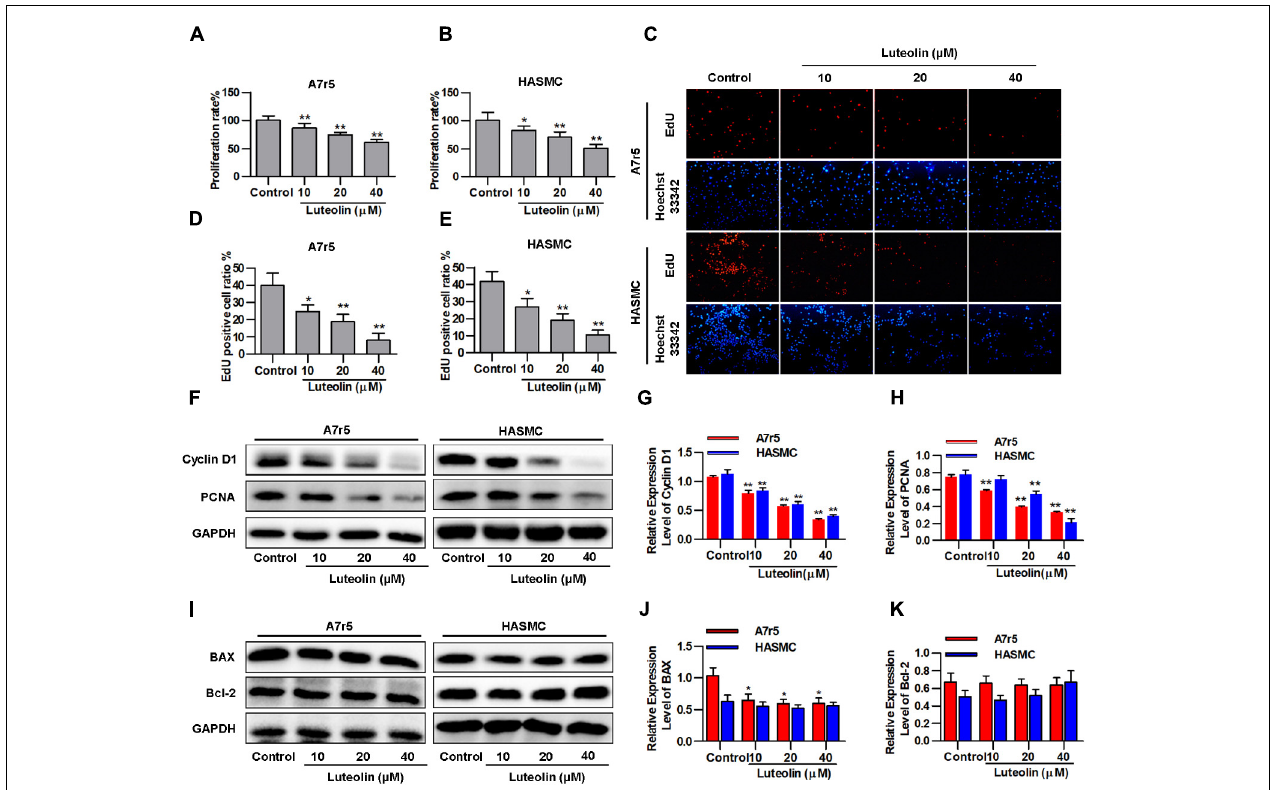
FIGURE 1 | Luteolin suppresses vascular smooth muscle cell (VSMC) proliferation without inducing apoptosis. (A , B) A7r5 and HASMC cells were incubated with different concentrations of luteolin (10, 20, and 40 µ M) for 48 h, and then VSMC proliferation was tested by MTS assays ( n = 6). (C) EdU proliferation assay. The red regions (EdU) in the images represent proliferating cells, and the blue regions (Hoechst 33324) represent the nuclei of all cells. (D , E) Percentage of EdU-positive VSMCs (the proliferation ratio was tested by assessing Hoechst 33324/EdU staining; n = 3). (F) A7r5 and HASMC cells were incubated with luteolin (10, 20, and 40 µ M) for 24 h, and the expression of Cyclin D1 and PCNA was tested by western blotting. (G – H) Relative expression levels of Cyclin D1 and PCNA ( n = 3). (I) Expression levels of BAX and BCL-2 were tested by western blotting. (J) Relative expression levels of BAX ( n = 3). (K) Relative expression levels of BCL-2 ( n = 3). Data are presented as the mean ± SD. ∗ P < 0.05, ∗ P < 0.01, compared to the control